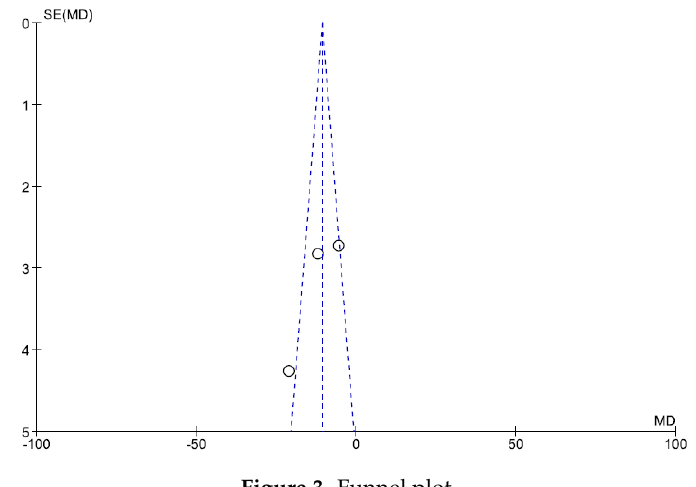
Figure 3. Funnel Figure 3. Funnel plot. Figure 3. Funnel plot.